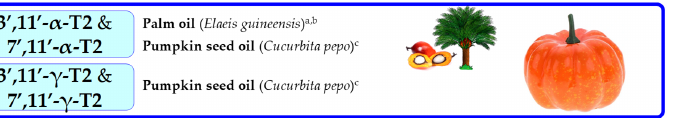
Figure 10. Sources of tocodienols (T2s). Superscripts ( a–c ) refers to the following literature positions: a , [52]; b , [73]; c , [16].